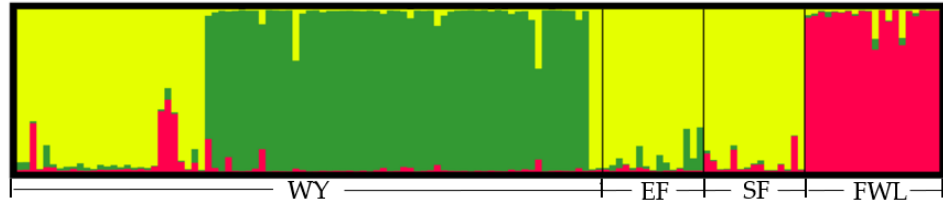
Figure 4. Model-based structure of the 137 tea germplasms.